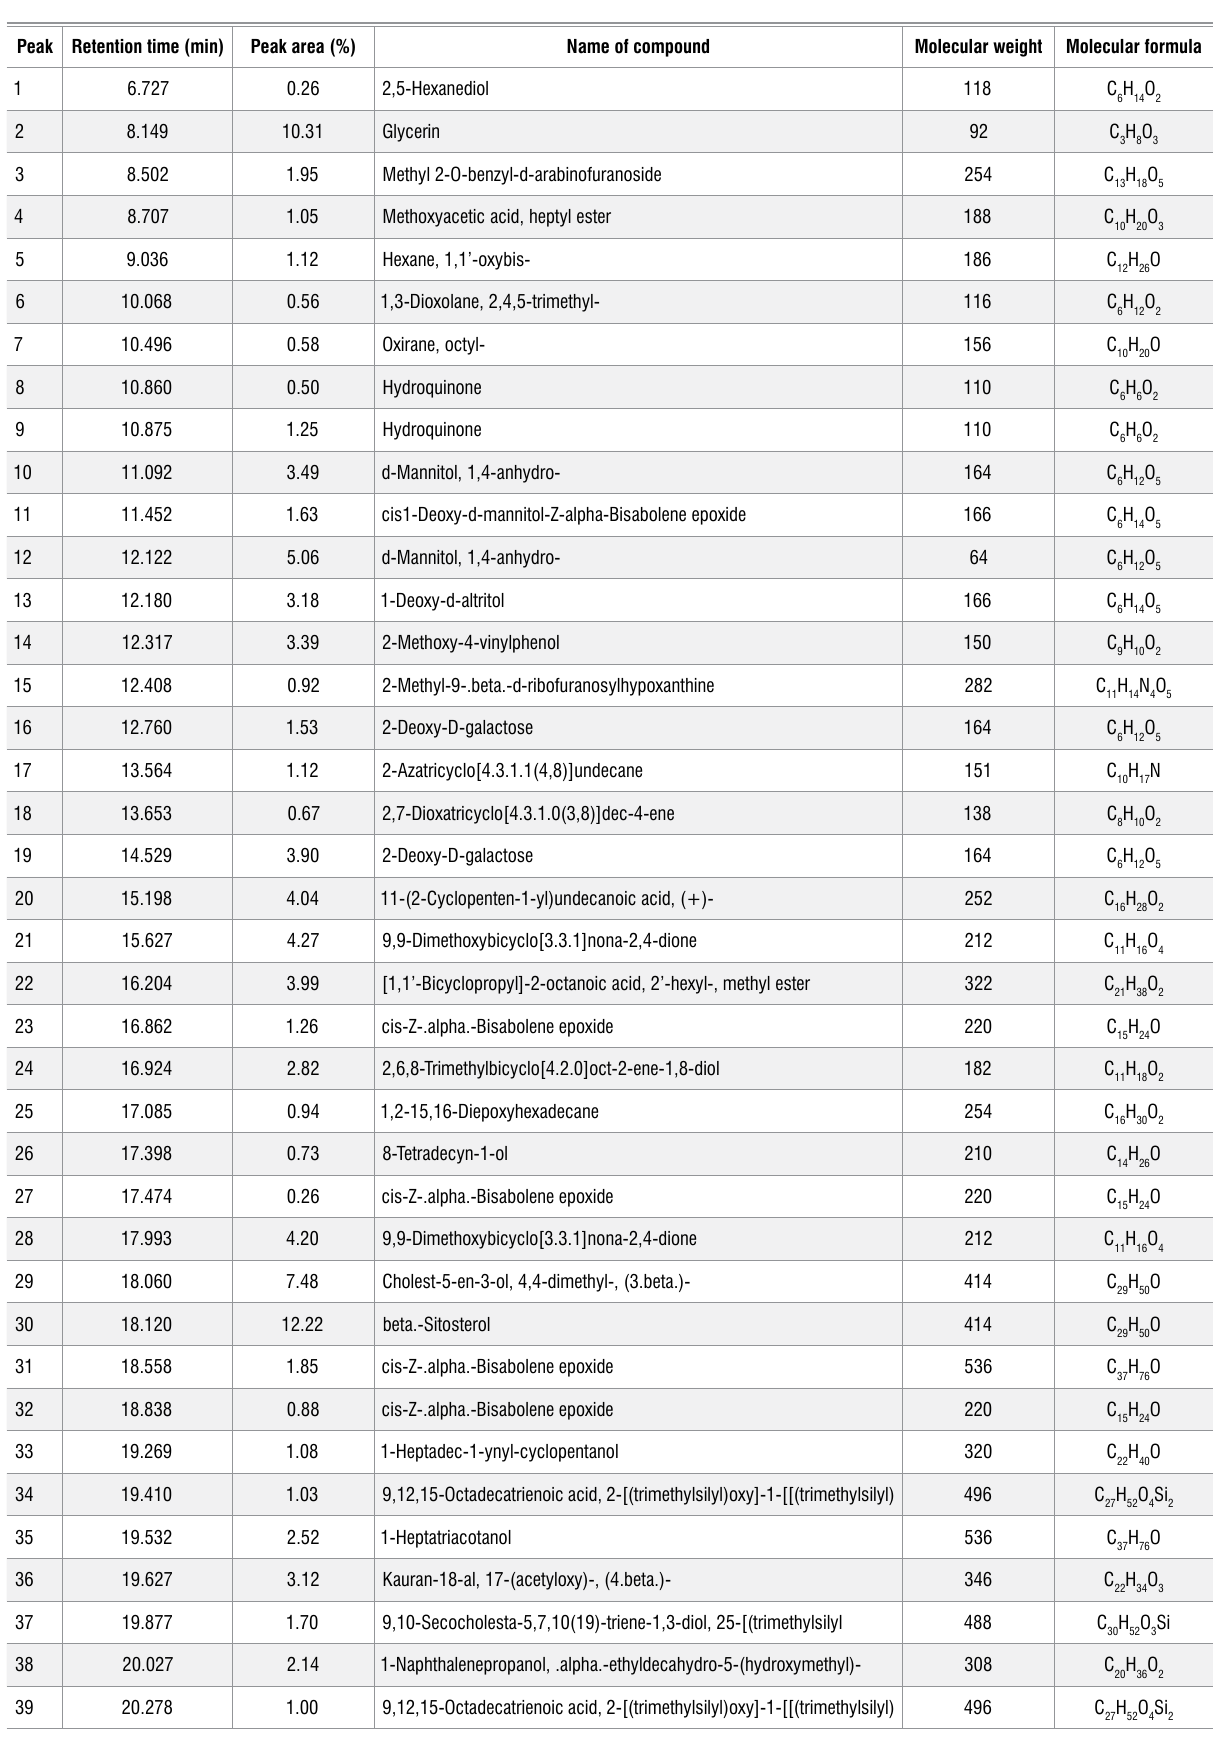
Gas chromatography–mass spectrometry results showing the phytochemicals, along with their corresponding peak areas, found in the Manihot esculenta aqueous leaf